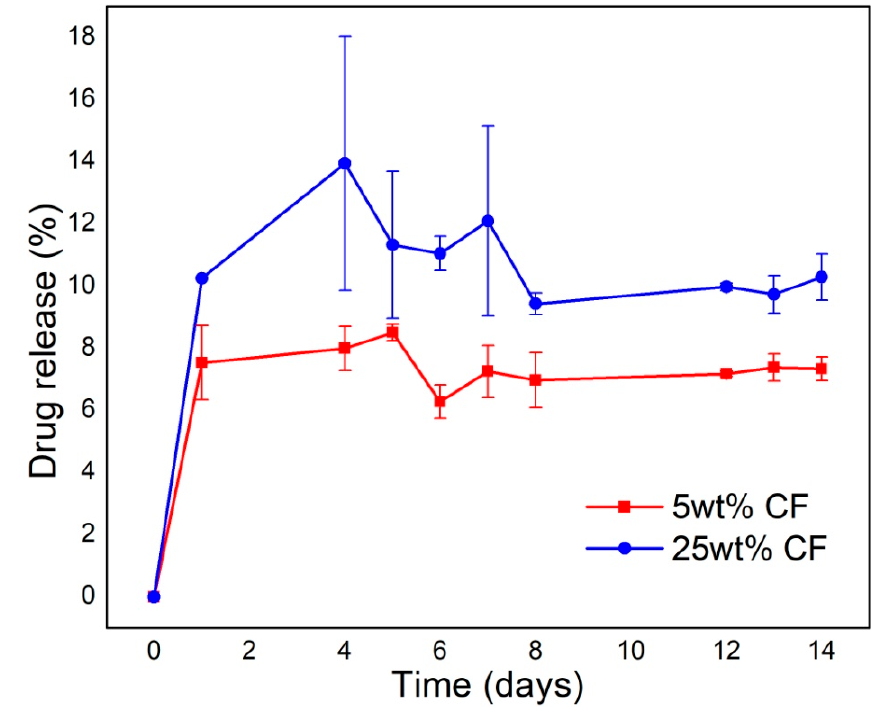
Figure 13. Release of the cefuroxime in percentages from the electrospun PCL/CF scaffolds.